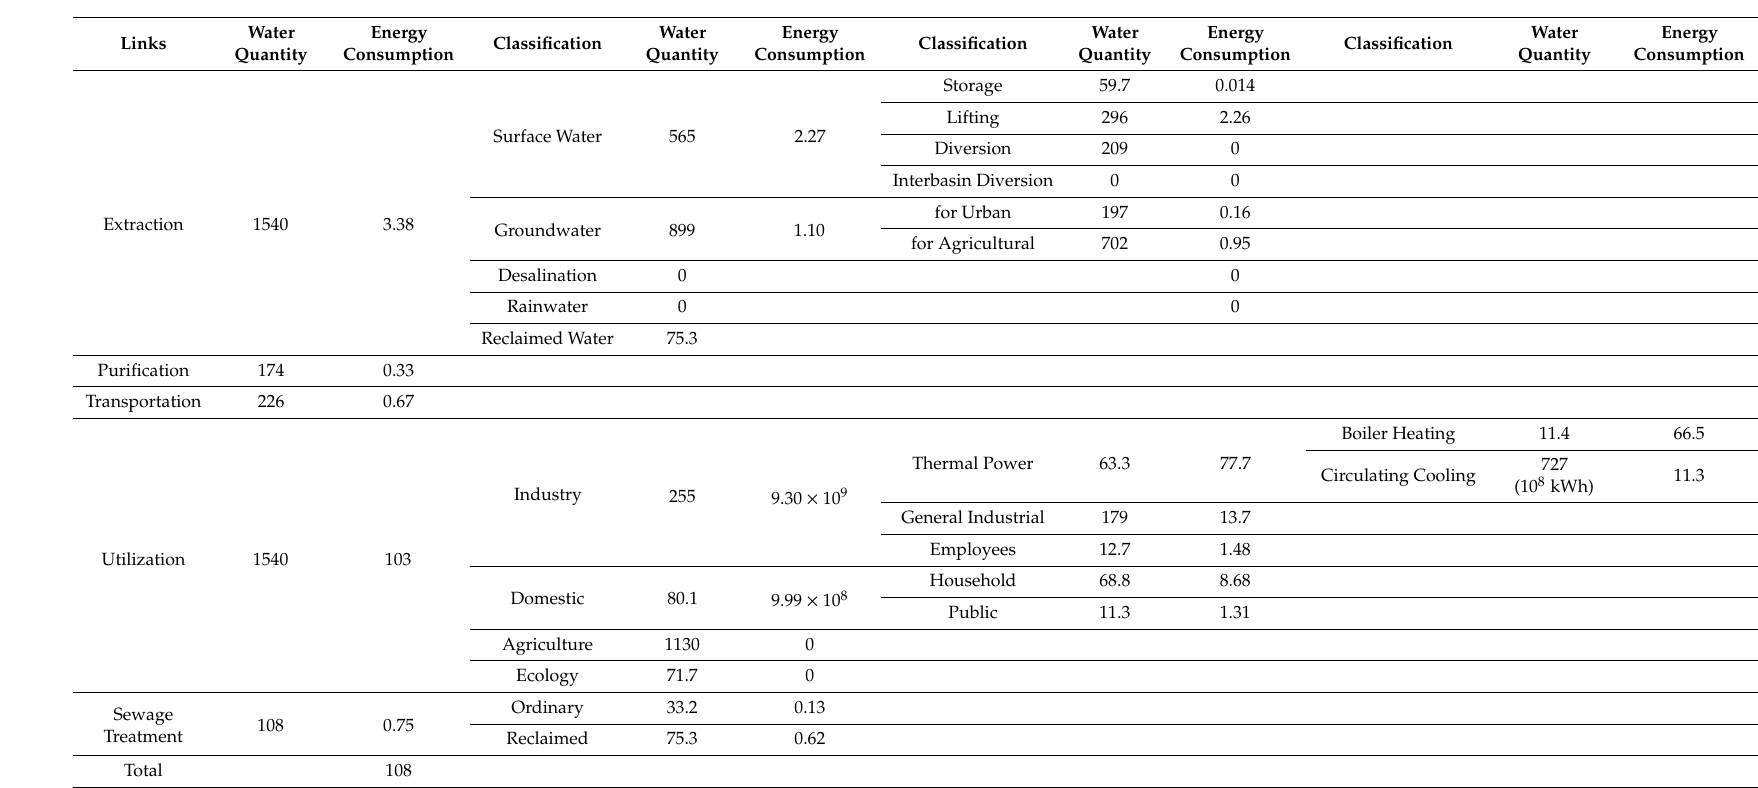
Table A5. Energy consumed through the use of water in Ordos, China, for